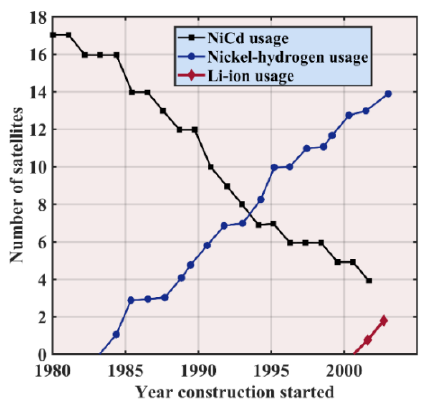
Figure 45. The precipitous rise of the usage of NiH 2 batteries and fall of the usage of NiCd batteries in satellites at the end of the 20th century [141].